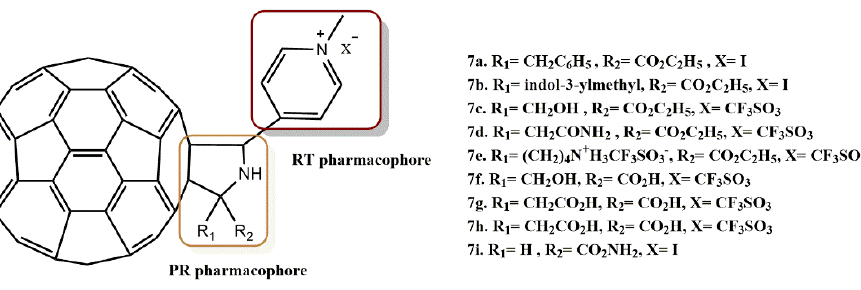
Figure 9. RT and PR pharmacophores of new active synthesized compounds 7a-i .